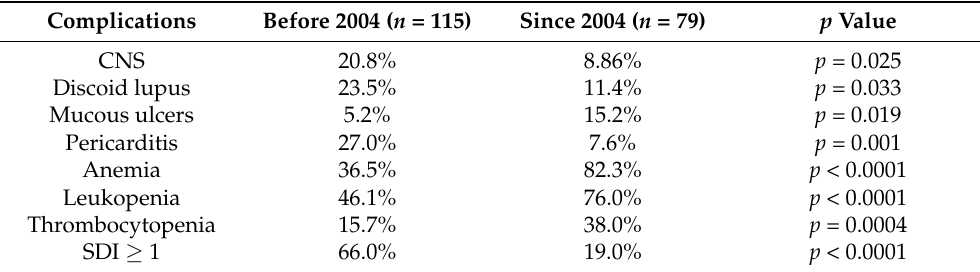
Table 6. Differences in the clinical symptoms and laboratory findings between patients of the APA negative group diagnosed with SLE before and since